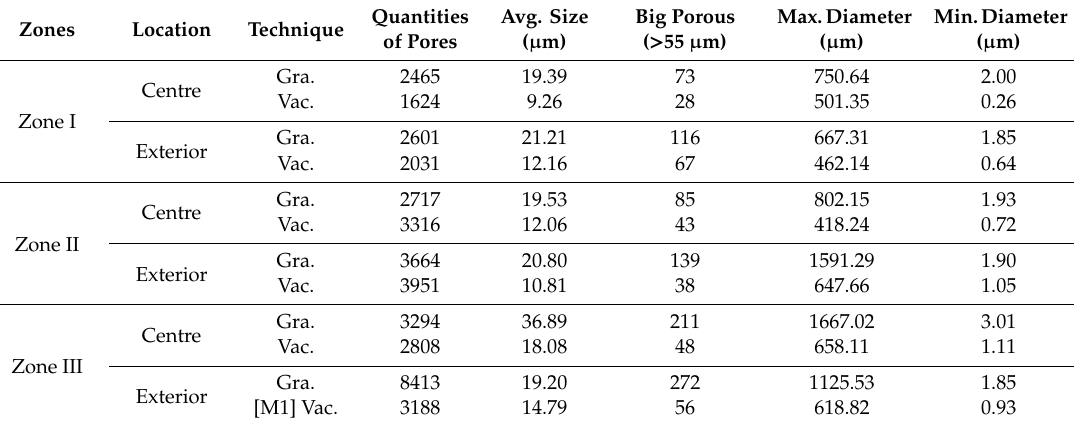
Table 6. Summary of porosity for both